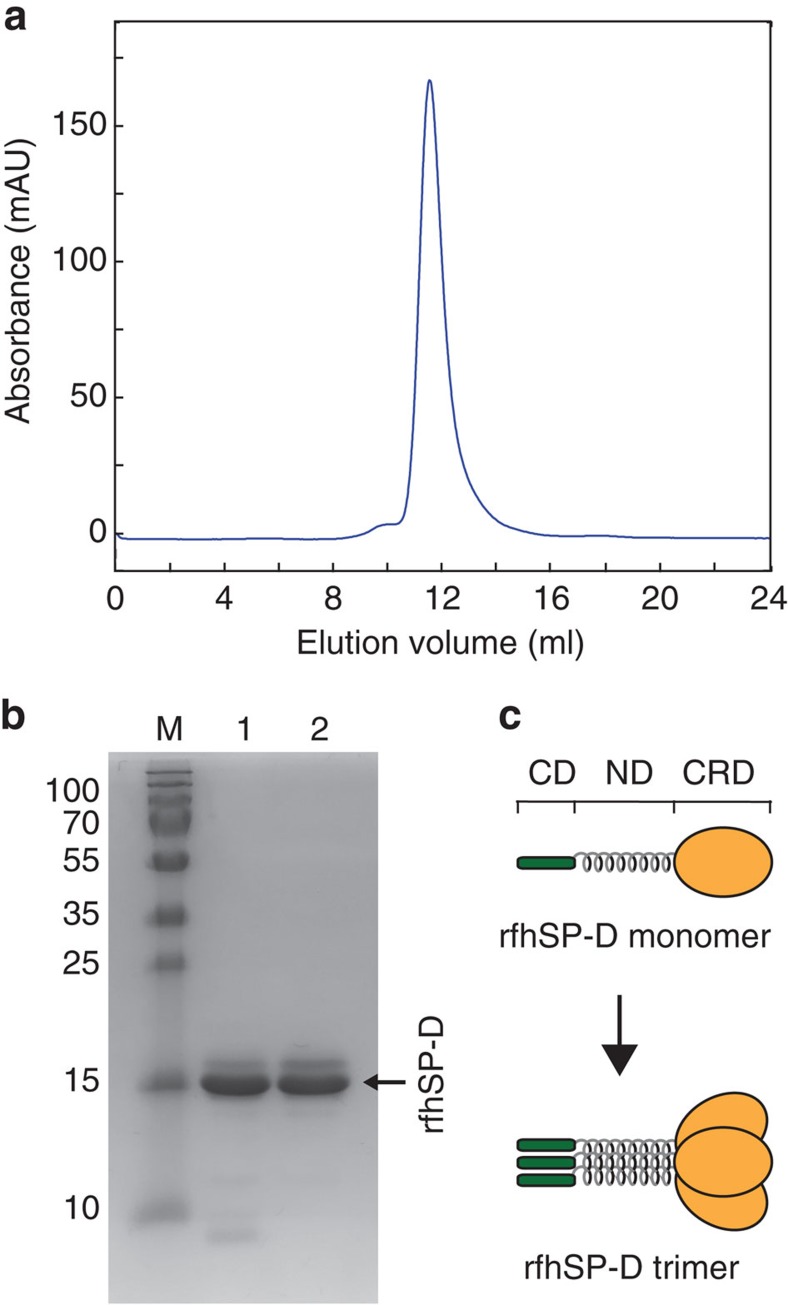
rfhSP-D adopts a trimer conformation.(a) Size-exclusion chromatogram of purified rfhSP-D, migrating as a well-defined population of trimeric protein, as confirmed with ESI-MS (Supplementary Fig. 10). (b) SDS-PAGE comparison of rfhSP-D after Ni-sepharose purification (lane 1) and after SEC separation of the main eluting peak (lane 2) shows an unchanged distribution of SDS-stable conformations. The molecular weights in kDa of a protein standard (lane M) are given to the left of the gel figure. (c) The rfhSP-D monomer comprises eight Gly-Xaa-Yaa repeats from the collagenous domain (CD), the α-helical neck domain (ND) and the carbohydrate-recognition domain (CRD). The functional trimer is formed as the neck domains from three monomer units assemble into a coiled-coil motif.